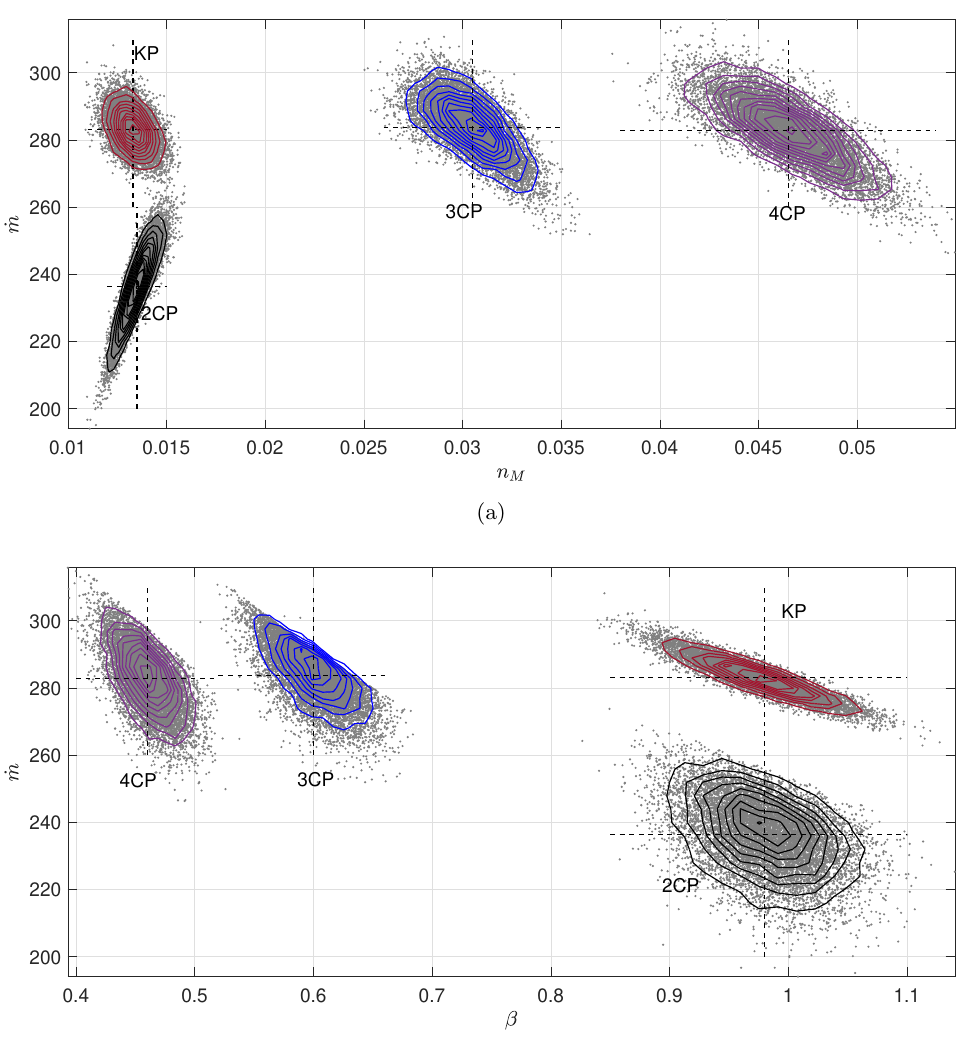
Figure 8: The scatter plots with the input parameters and output flow rate. (a) for n M and (b) for β .